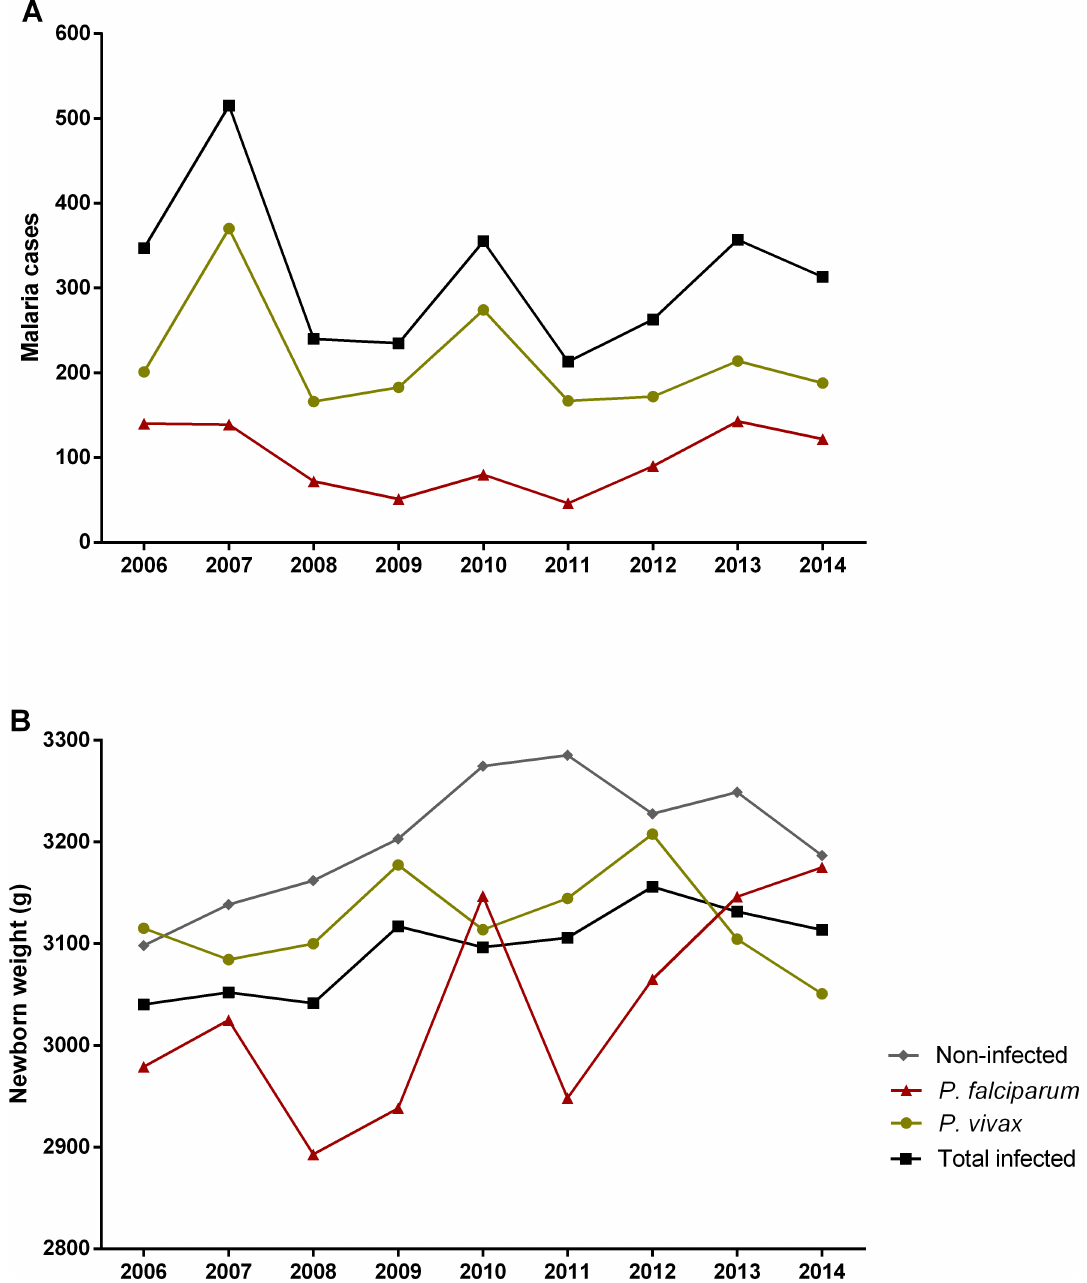
Fig 3. Time-series of gestational malaria cases between 2006–2014. (A) Number of gestational malaria cases per species, (B) mean birth weight of newborns from non-infected and infected women during